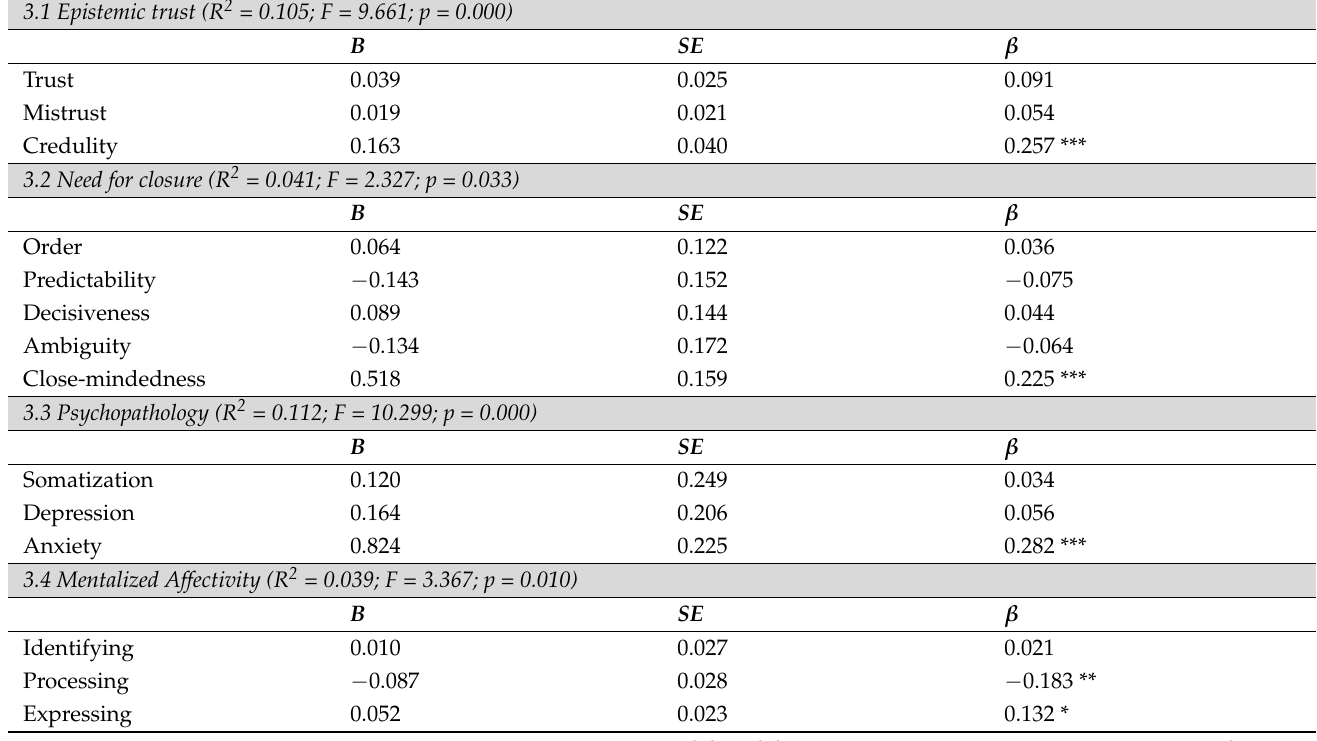
Table 5. Hierarchical multiple regression analyses on psychological variables (n = 333).